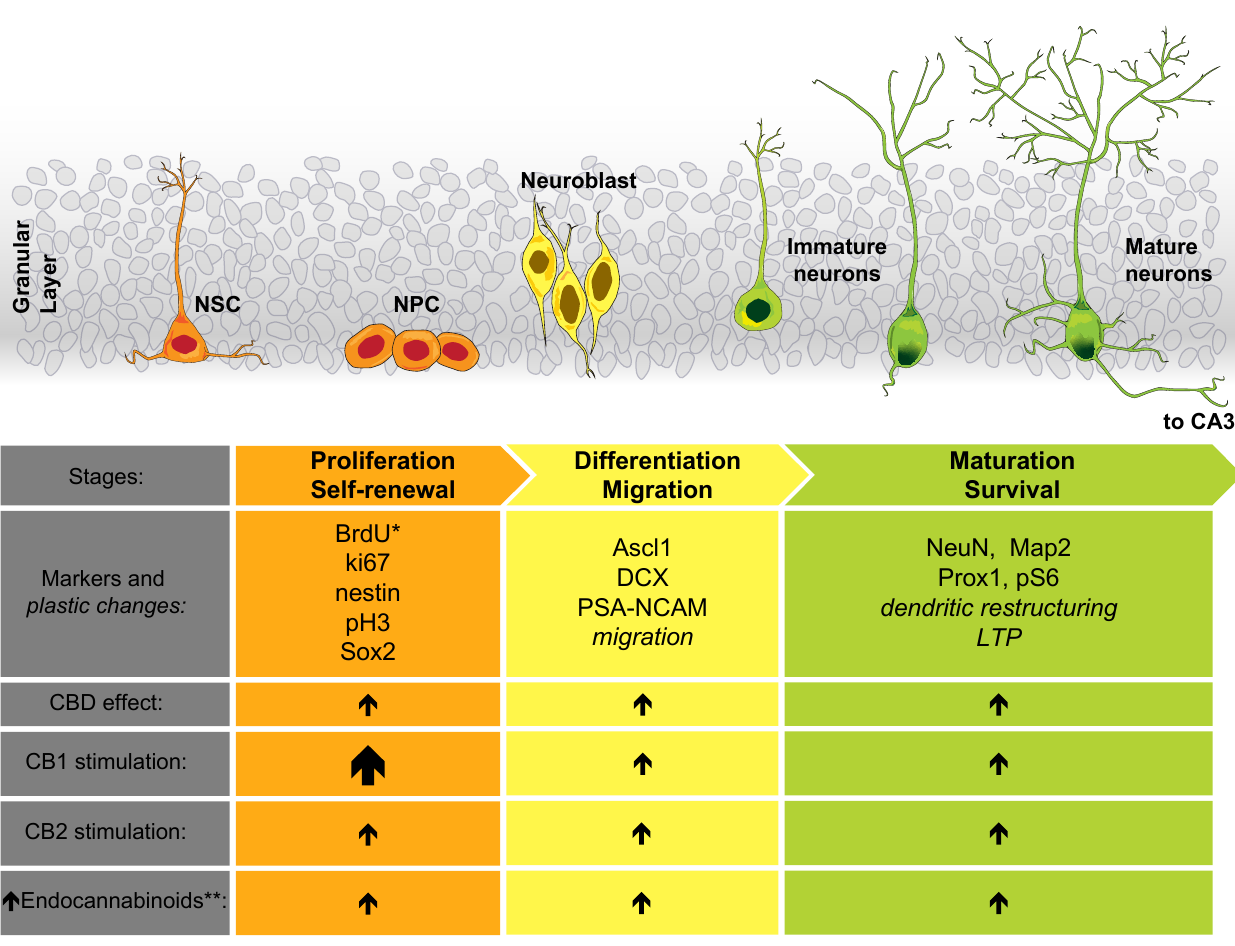
Figure 2. Participation of the ECS in adult hippocampal neurogenesis. We illustrate the distinct cell morphologies associated with the different stages of adult hippocampal neurogenesis at the top of the figure. Below, we include some of the molecular markers and plastic changes (italics) associated with the specific neurogenic stages. This list is not exhaustive; it mainly includes the markers referred to in the text. In the last rows, we show the effect of stimulating the ECS (a larger arrow represents a major number of references supporting this effect). * As mentioned in the text, BrdU is not an endogenous molecular marker of neurogenesis. ** To increase the concentration of endocannabinoids, we primarily refer to the inhibition of their degrading enzymes. Abbreviations (not described in the main text): Achaete-scute family BHLH transcription factor 1 (Ascl1), microtubule associated protein 2 (MAP2), phospho-histone 3 (pH 3), polysialylated-neural cell adhesion molecule (PSA-NCAM), prospero homeobox 1 (Prox1), and SRY-box transcription factor 2